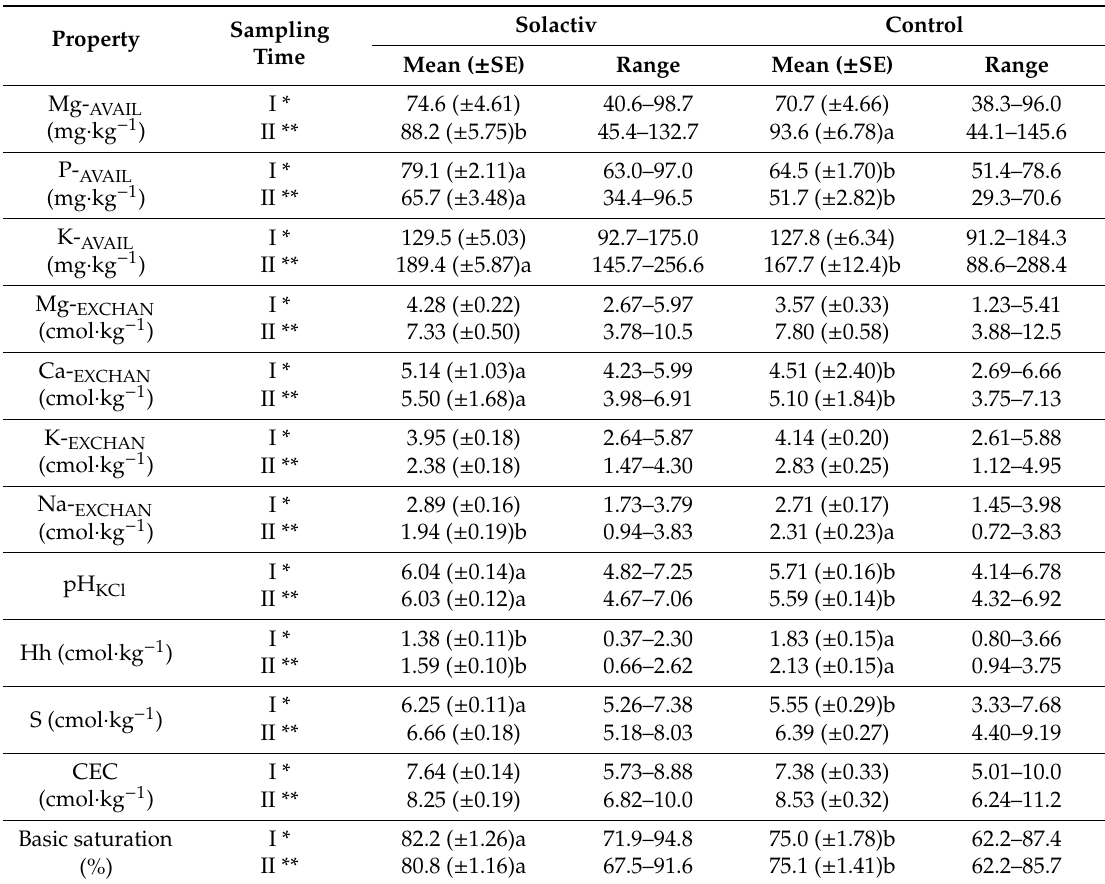
Table 3. Available and exchangeable forms of the macronutrients and some sorption soil properties as a ff ected by the conditioner application, mean ( ± SE) for the studied